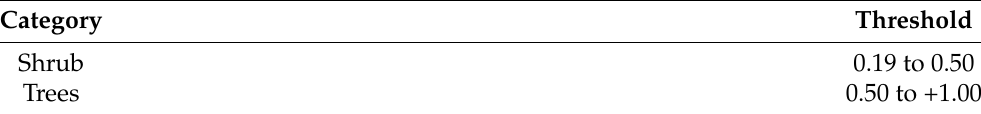
Figure 5. Three different classification levels for City of Melbourne (( a ) Level-1 classification, ( b ) Level- 2 classification, ( c ) Level-3a classification, and ( d ) Level-3b classification). Note that level-3 contains two classifications level-3a and level-3b for shrub and trees, respectively. Table 3. Level-2 classification of vegetation region into shrub and trees